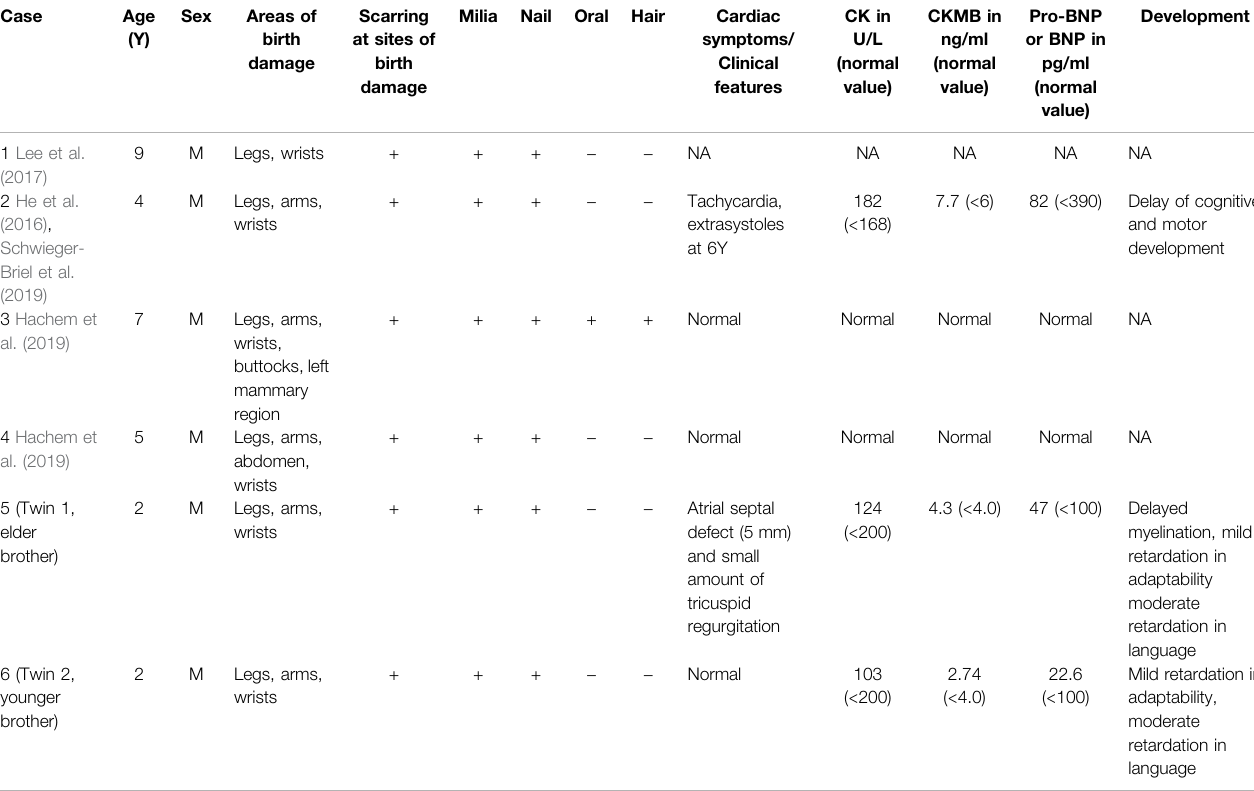
TABLE 1 | Summary of clinical features of individuals with c.2T > C pathogenic variant in KLHL24 .